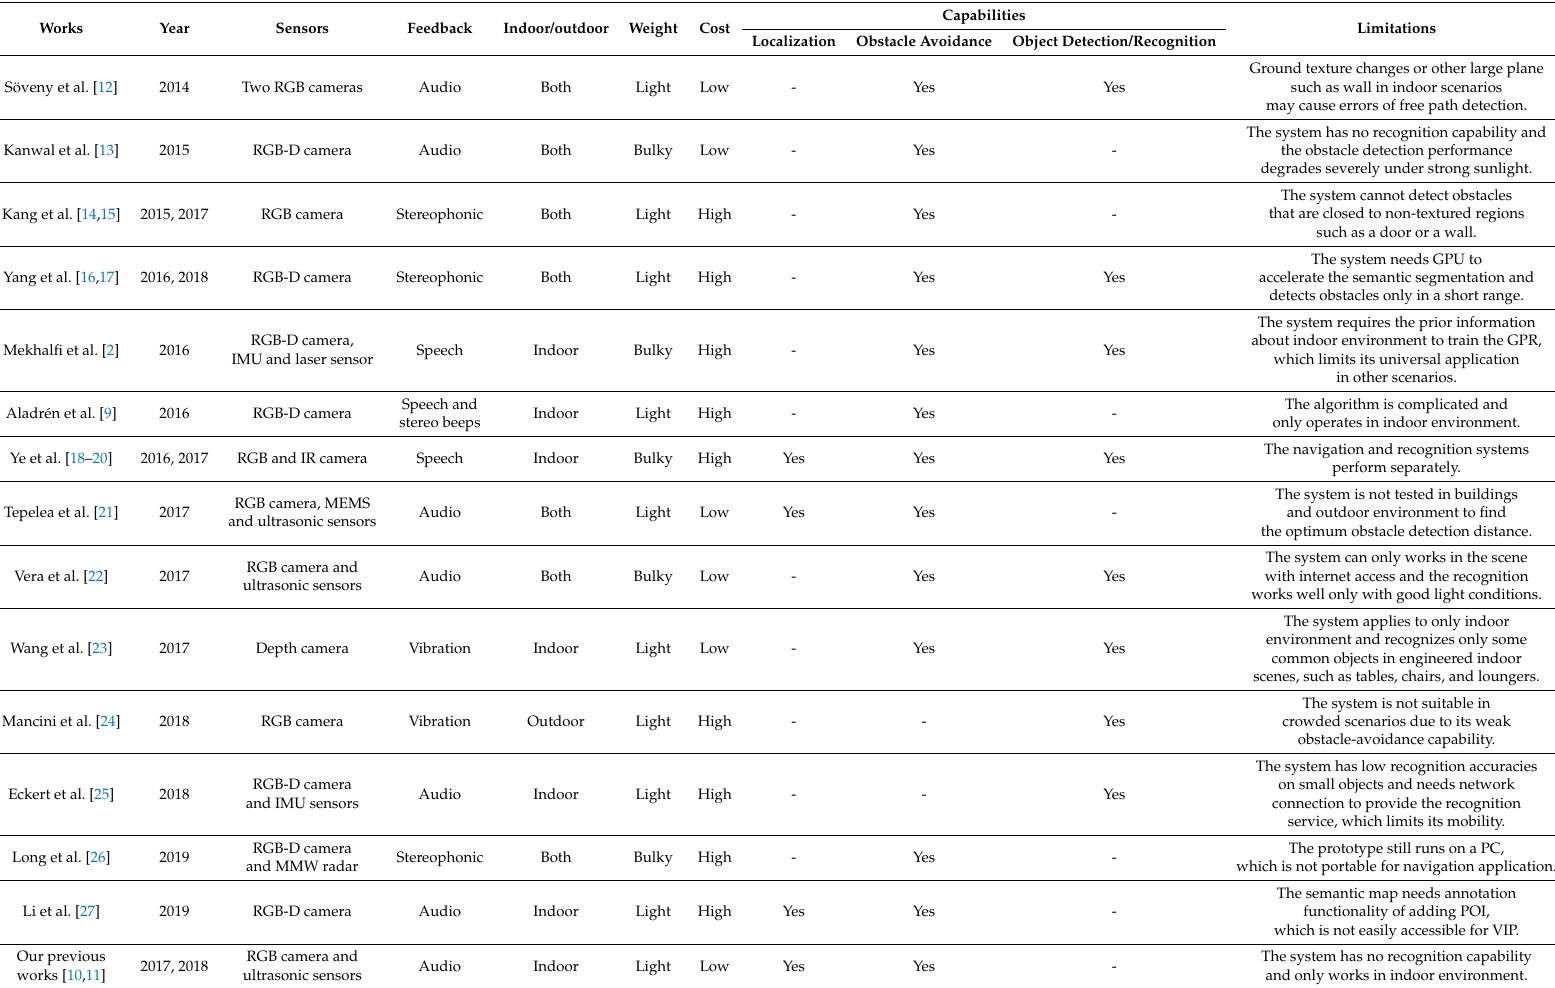
Table 1. Summary of vision-based assistive systems for